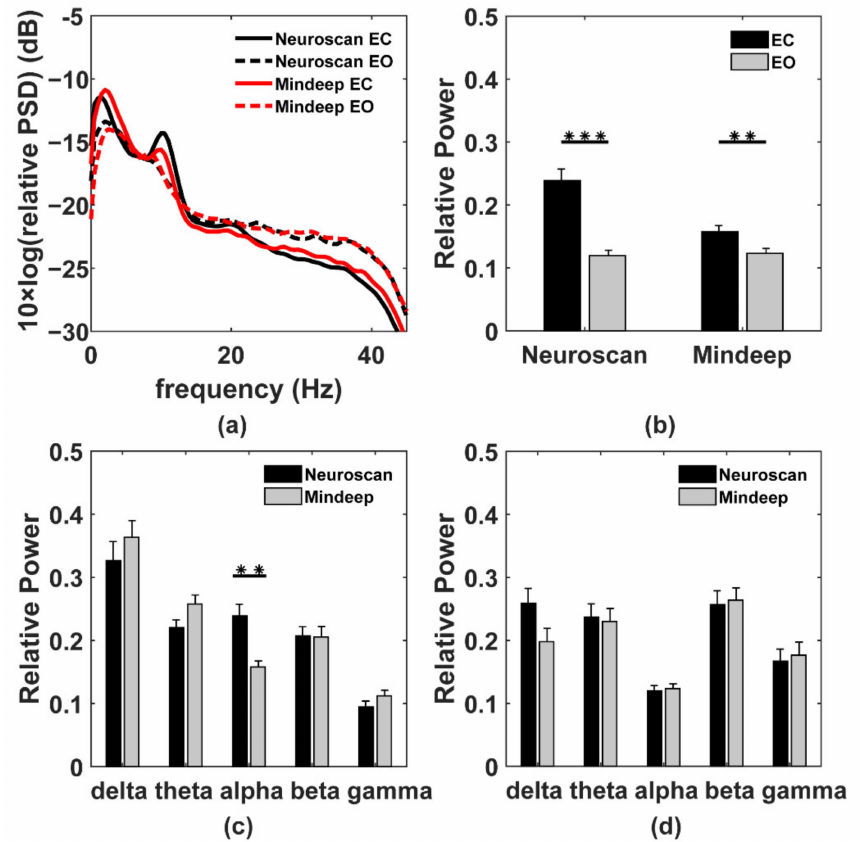
Figure 6. Power spectral density results. ( a ) The relative power spectral density curve for Neuroscan and Mindeep in EC and EO. The black solid line is the PSD curve for Neuroscan in EC. The black dotted line is the PSD curve for Neuroscan in EO. The red solid line is the PSD curve for Mindeep in EC. The red dotted line is the PSD curve for Mindeep in EO. ( b ) The alpha band relative power of Neuroscan and Mindeep in EC (black bar) and EO (grey bar). The relative power of delta, theta, alpha, beta, and gamma band for Neuroscan (black bar) and Mindeep (grey bar) in ( c ) EC state and ( d ) EO state. The significant difference (*** represented p < 0.001, ** represented p < 0.01) was shown in ( b – d